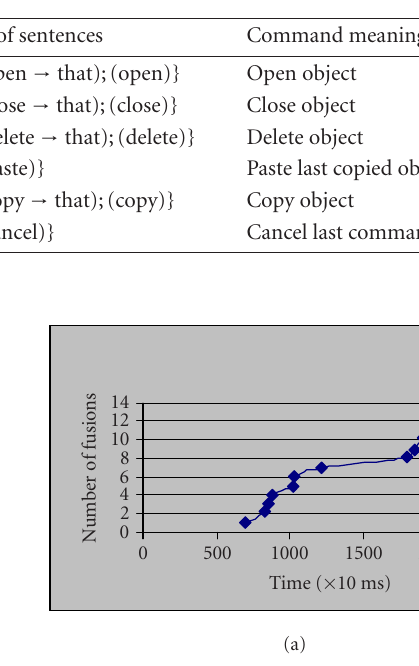
Figure 11: (a) Achieved semantic fusions. (b) Canceled